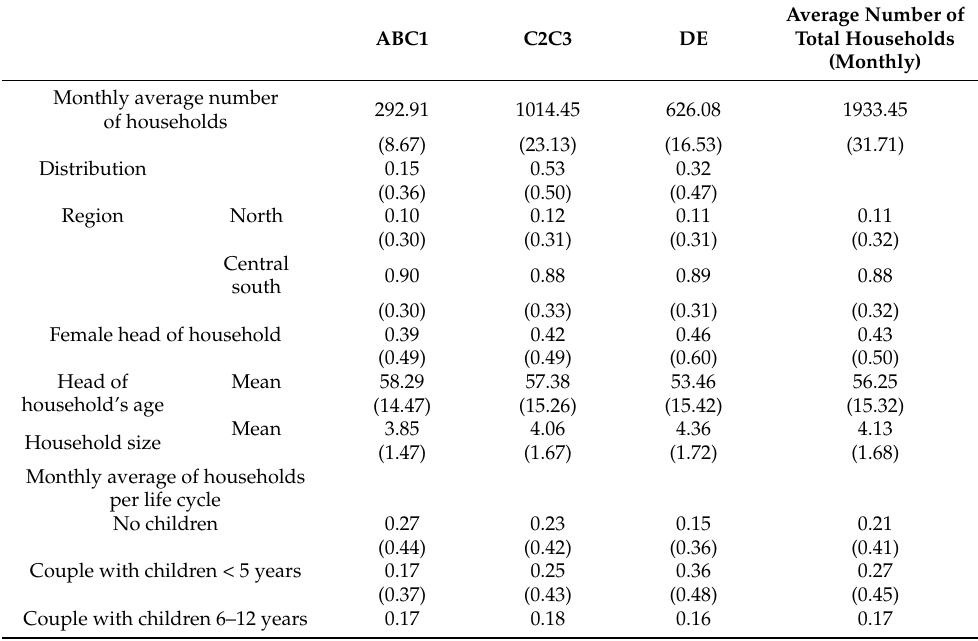
Table 1. Characteristics and distribution of the total sample and by SES